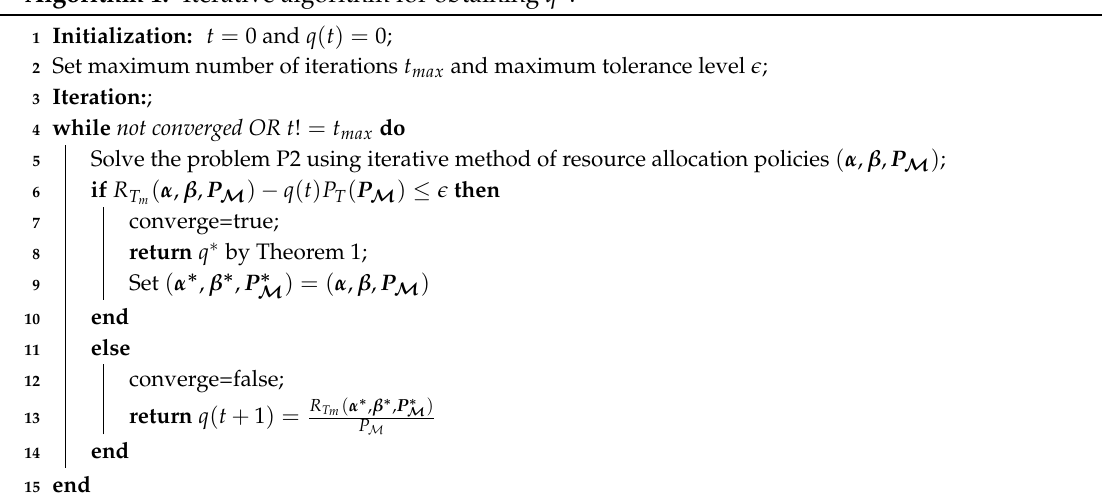
Algorithm 1: Iterative algorithm for obtaining q ∗